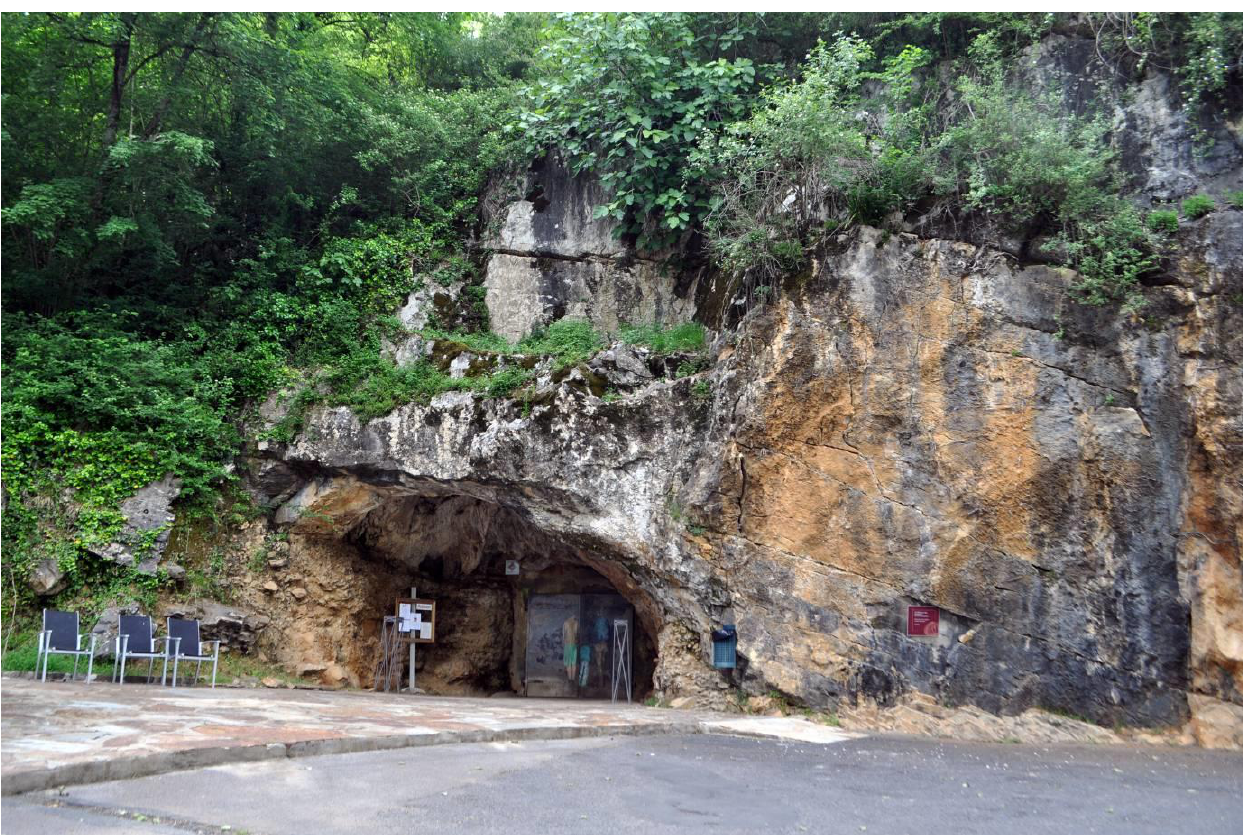
Figure 2. Current entrance for touristic visitors to the Isturitz